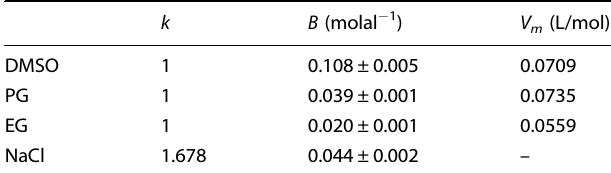
Table 6. Dissociation constants and virial coef fi cients for Eq. (8) 26 and the molar volume 52 of each cryoprotectant for Eq.